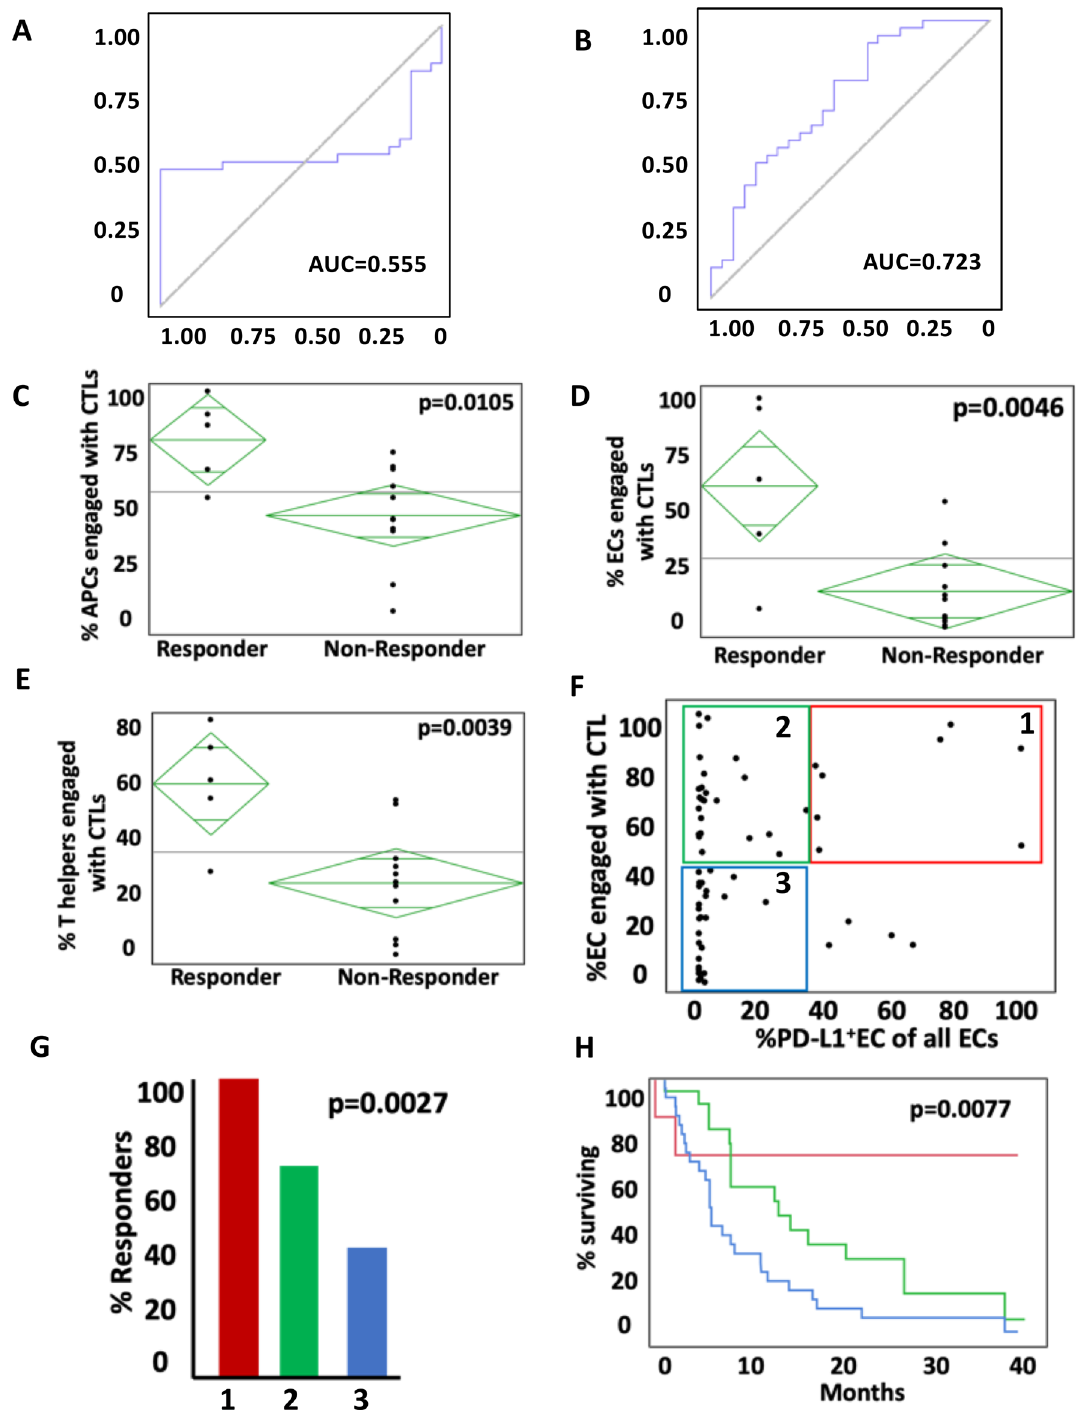
Figure 5. Predictive ability of spatial relationships in addition to tumor PD-L1 to predict non-response to ICI. ( A ) AUC of tumor PD-L1 alone to predict non-response versus ( B ) AUC of tumor PD-L1 and spatial relationships combined together. ( C – E ) Examination of 17 patients with PD-L1 < 1%, who are thought to not likely benefit from ICI. Even in the absence of PD-L1, engagement of CTLs with APCs ( C ), ECs ( D ), and HTLs ( E ) were able to separate responders from non-responders. ( F ) Examining the interplay between endogenous immune reactivity and checkpoint inhibition by dividing patients into 3 cohorts based on EC-CTL engagement and EC PD-L1 expression. ( G ) Cohort 1, which has high engagement and high PD-L1 expression likely representing reactive upregulation defined the patients that all had a response to ICI and also had the longest median overall survival ( H